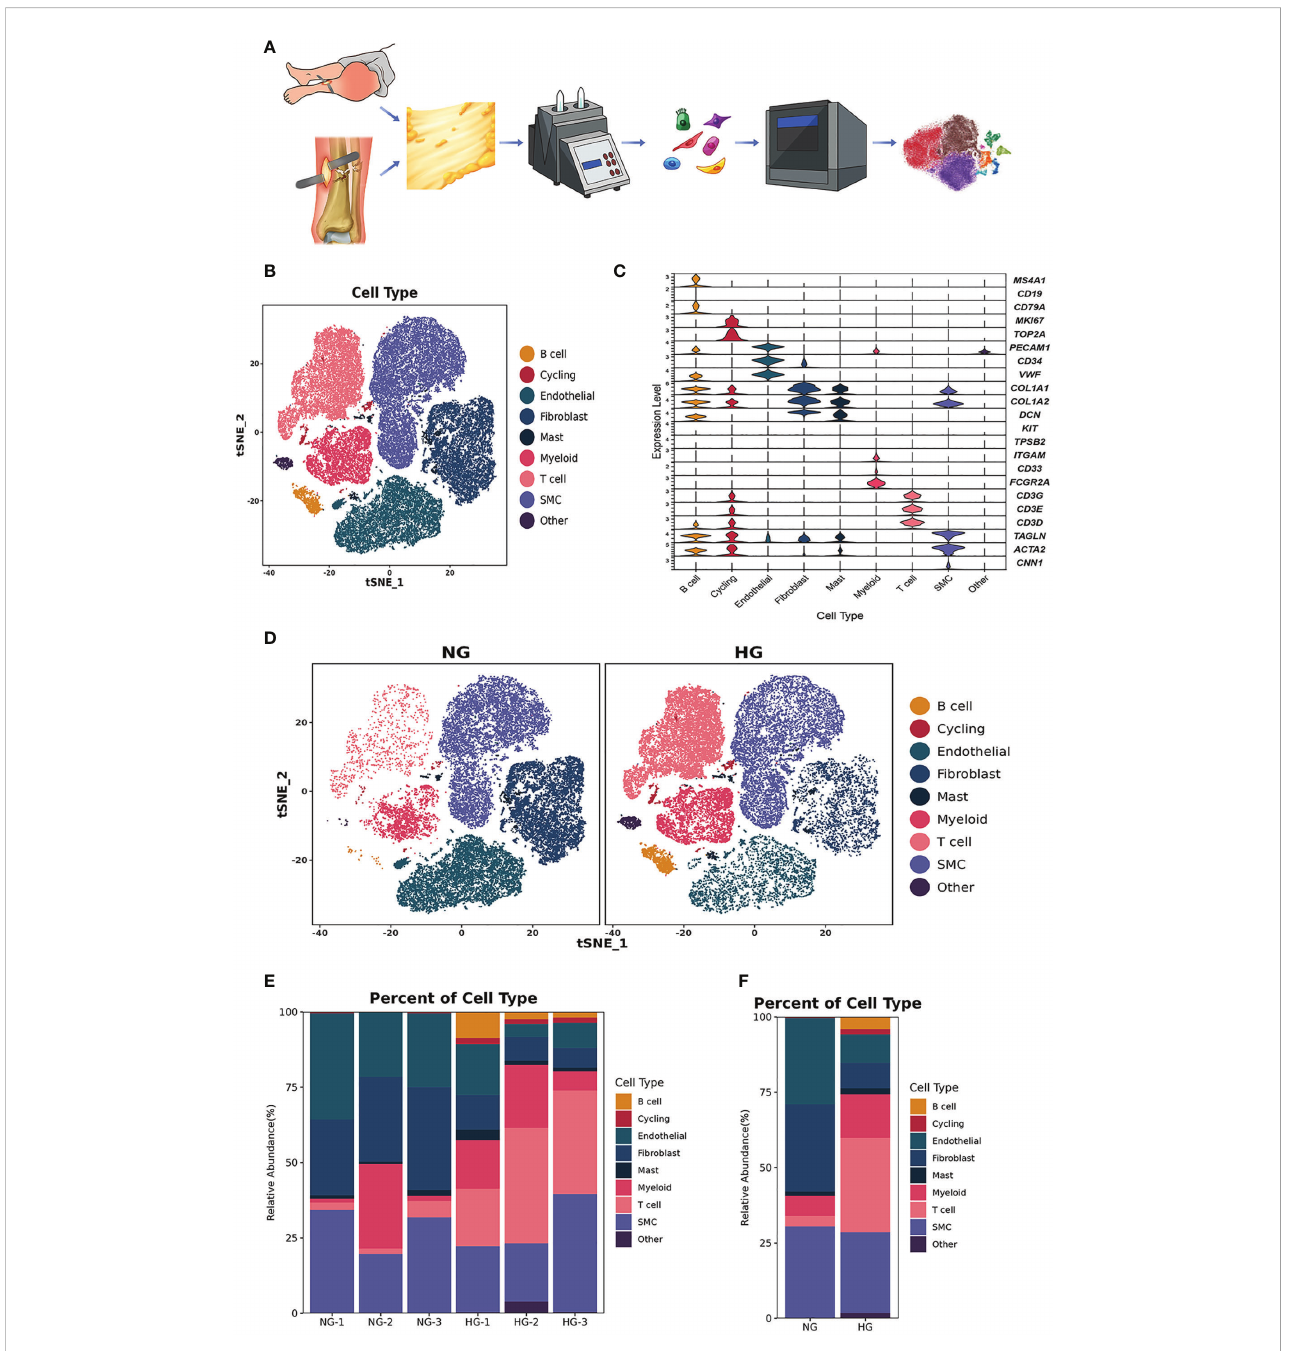
FIGURE 1 Clustering and classi fi cation of the cellular landscape of deep fascia tissue. (A) Overview of the experimental work fl ow. (B) tSNE visualization of cell cluster from deep fascia tissue. (C) Violin plots showing marker genes across cell clusters. (D) tSNE visualization of cell cluster from deep fascia tissue in HG and NG. (E) Bar plots showing the relative percentage of cell cluster for each sample as in (A) . (F) Bar plots showing the relative percentage of cell cluster in HG and NG. scRNA-seq, single-cell RNA sequencing; HG, high stress group; NG, normal stress